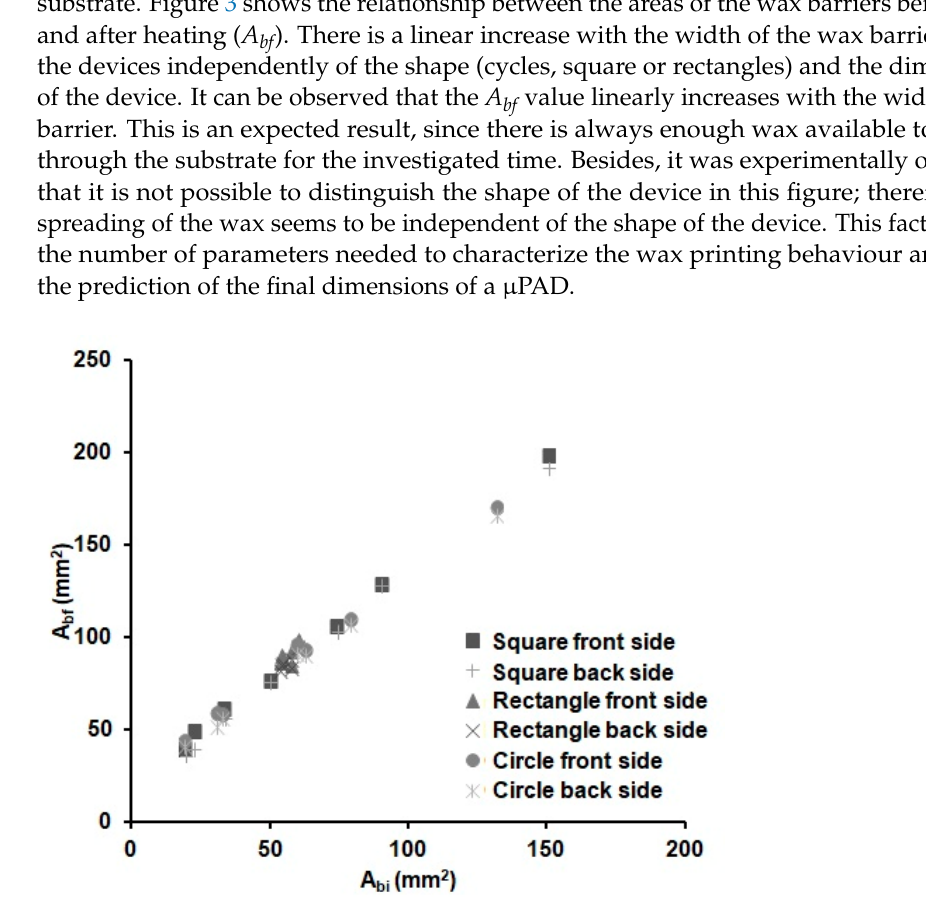
Figure 3. Variations of the front (square, triangle and circle markers) and back (crossed markers) wax barrier areas before (A bi ) and after (A bf ) heating for 6 min at 125 °C of the devices from Table 2 ( n = 8 per device), with different shapes and barrier width values.